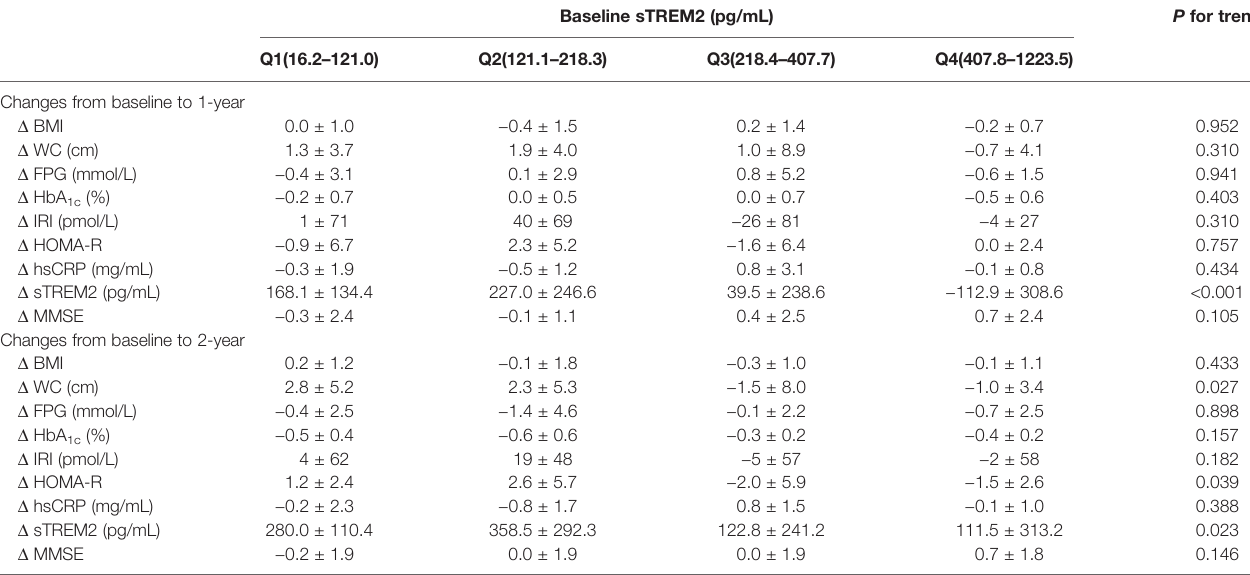
TABLE 3 | Relationships between sTREM2 levels at baseline and changes in parameters at 1 and 2 years of follow-up in HbA 1c -decreased